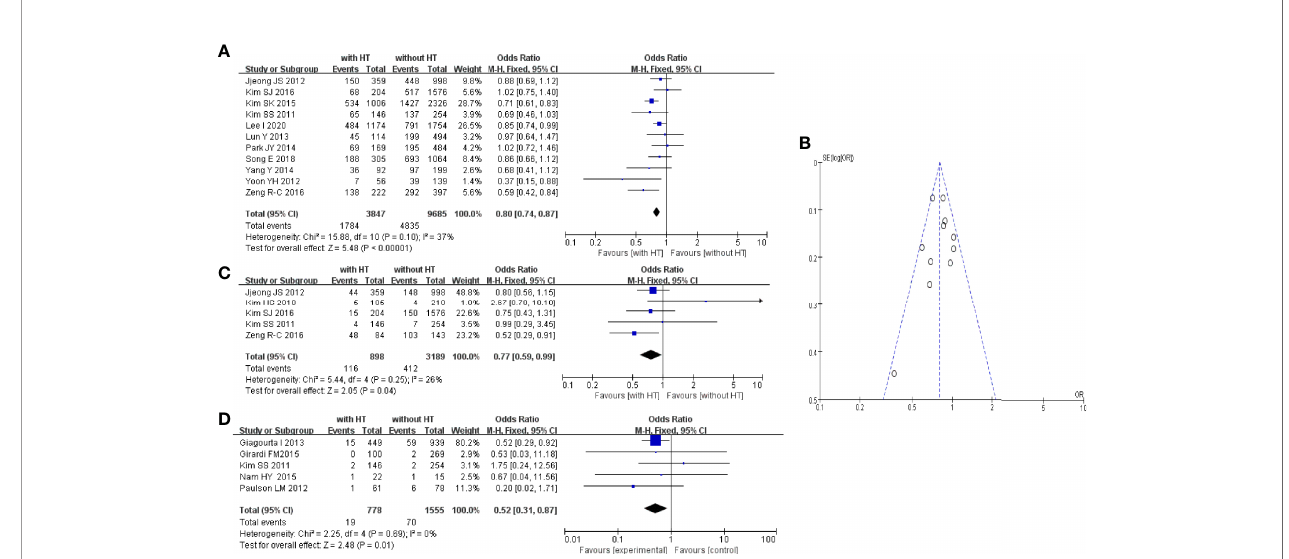
FIGURE 4 | HT and central LN metastasis: (A) forest plot, (B) funnel plot; (C) Forest plot of HT and lateral LN metastasis; (D) forest plot of HT and distant